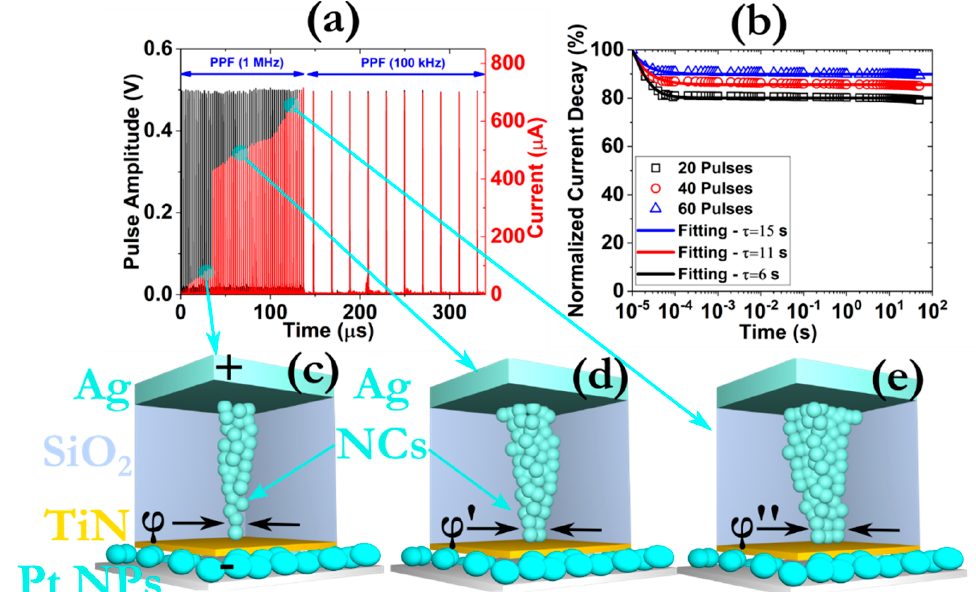
Figure 6. ( a ) Experimental verification of the paired-pulsed facilitation (PPF) effect by monitoring the post-synaptic current response after the application of a train of 70 pulses with the same width (100 ns), amplitude (0.5 V) and different frequency; ( b ) normalized current decay distribution as a function of time demonstrating long-term plasticity (LTP) synaptic behavior. The data were collected after applying a set of 95 pulses, with a frequency of 100 kHz, after the enforcement of 60 pulses, with frequency 1 MHz; ( c – e ) schematic representation of the CF growth procedure during the application of the consecutive pulsing scheme. The symbol φ stands for the effective diameter of the CF.